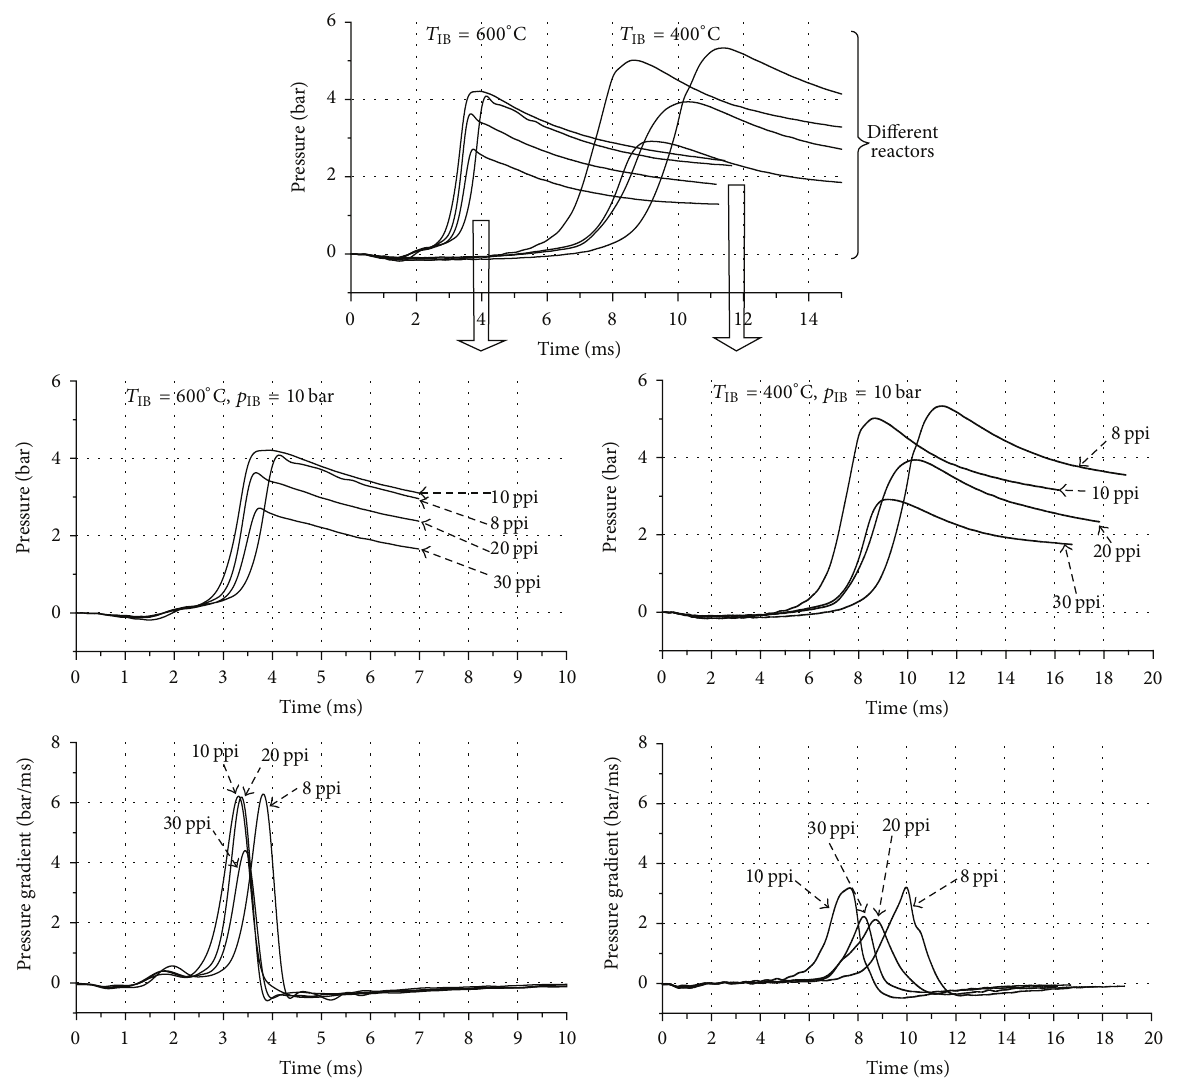
Figure 10: Comparison of pressure histories and pressure gradient distributions for heat release in different SiC foam porous reactors after fuel injection starts at two initial reactor temperatures 400 ∘ C (right) and 600 ∘ C (left) and for initial pressure 𝑝 injected fuel is 23.7